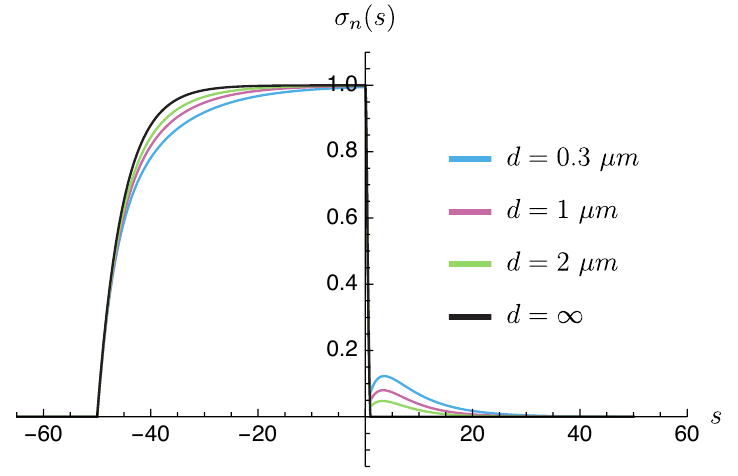
= ( σ ( t ) − σ ) / ( σ − σ ) of one Figure 4: Evolution of the normalized variance σ n f i f particle in response to the symmetric protocol for different values of the distance d between the particles. The parameters of the ESE protocol (shaped as in Fig. 2) are = 2ms, k = K / K = 1.5, K = 10 − 6 N / m, and Γ = 9.42. Without the following: t f f f i i coupling (when d = ∞ ) the response to the ESE is shortcut to t . The hydrody- f namic coupling results in a rebound on the variance curve, which no longer reaches ≈ 15ms. its equilibrium value at t , but after a few natural relaxation times τ f relax As expected from experimental results, the smaller the distance d , the higher the rebound and so the deviation from the 0-coupling